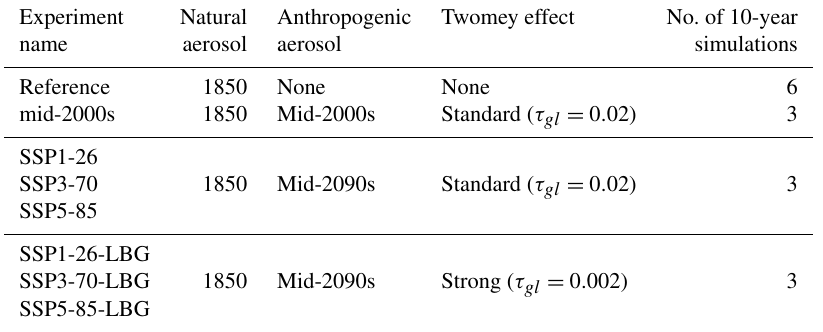
Table 1. Experiment set-up for estimating forcing. Experiment